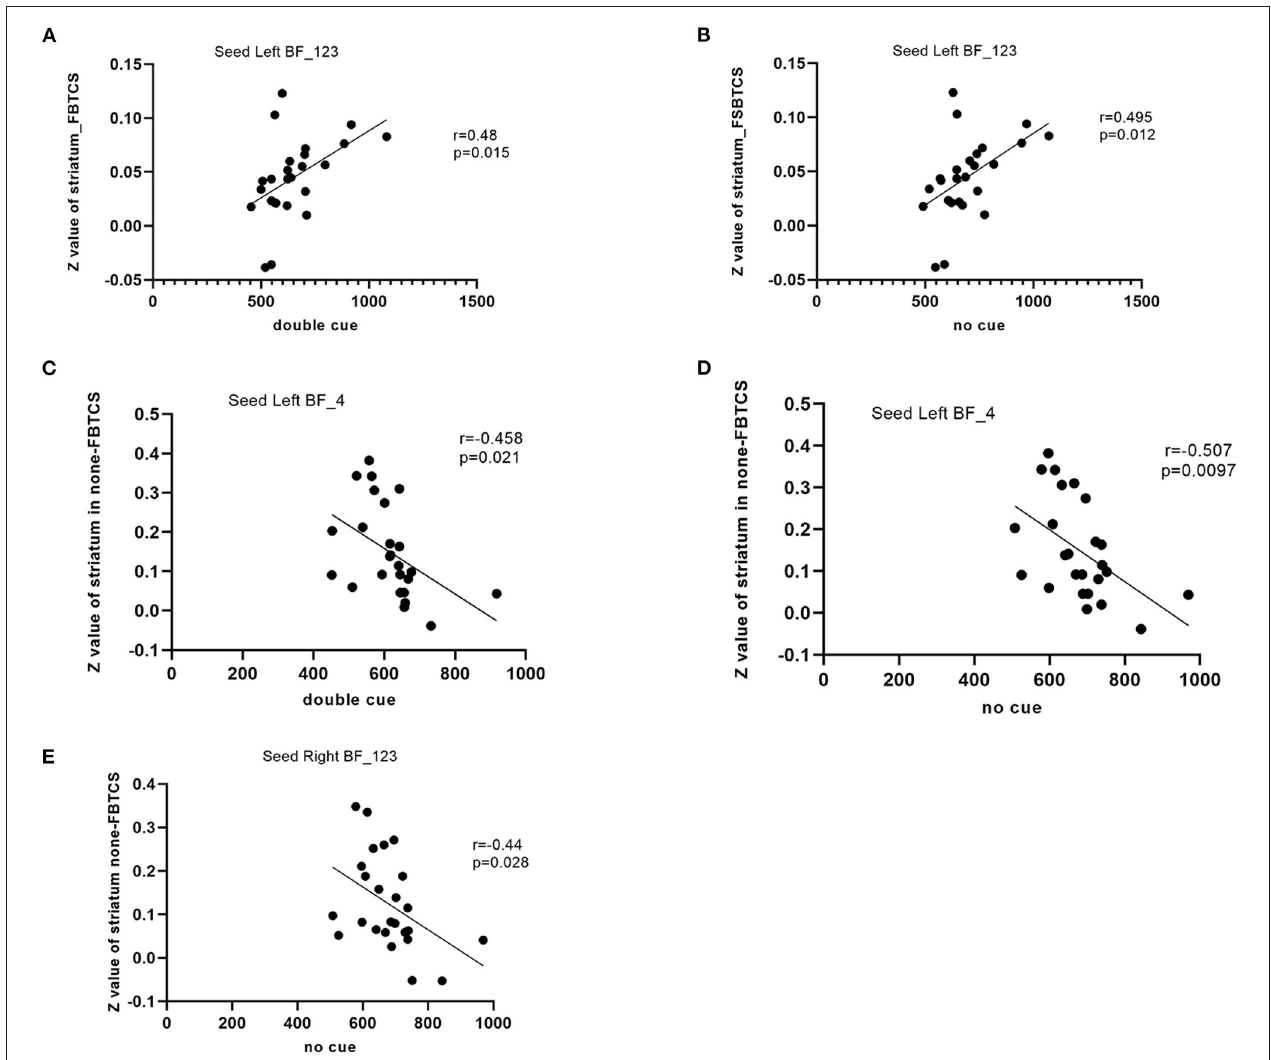
FIGURE 3 | (A–E) Scatter plots depicting the correlations between the altered resting-state functional connectivity (RSFC) in the BF subregions and the clinical variables in patients.